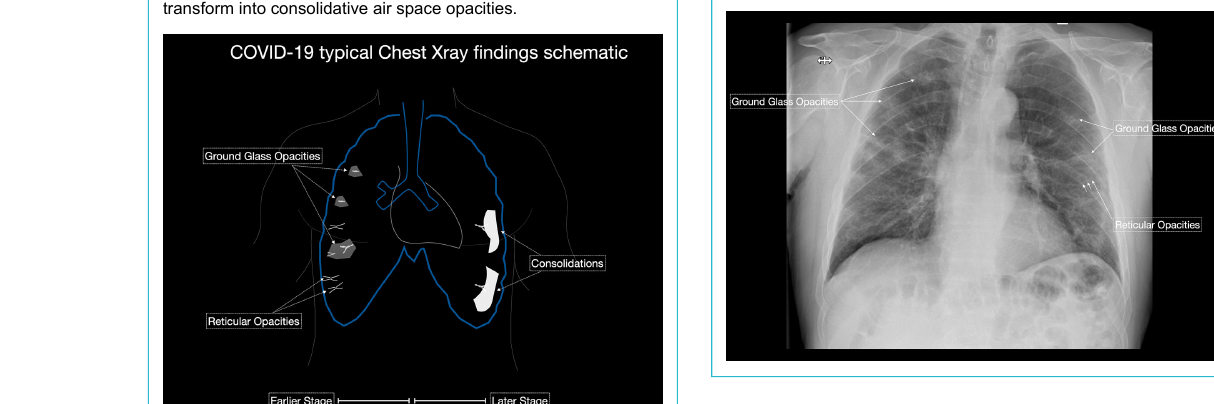
Figure 2: A 71-year-old male patient with cough, intermittent fever and progressive dyspnoea. Early findings were predominantly pe- ripheral ground glass opacities and reticular opacities. No consoli- dations or pleural effusions are seen. Subsequent nasopharyngeal RT-PCR test was positive for COVID-19.